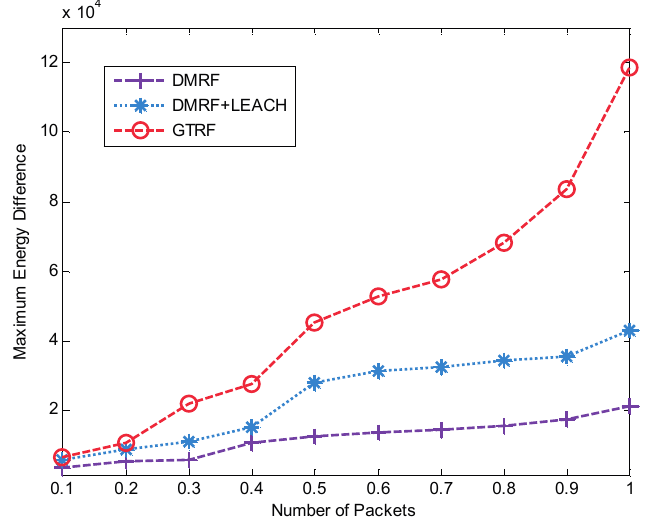
Figure 11. Lifetime of the network without selfish